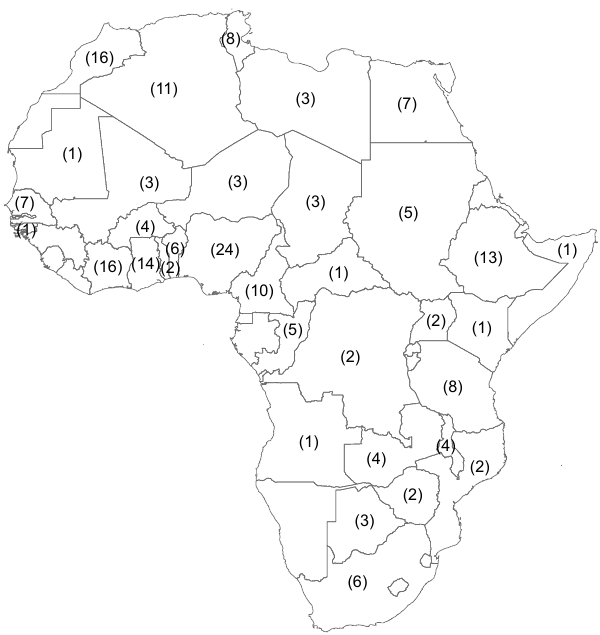
Figure 2. Distribution of studies identified across Africa.